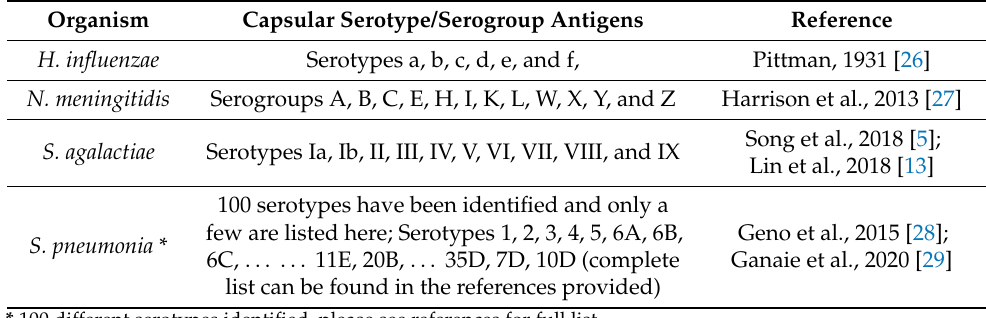
Table 1. Capsular antigens of Haemophilus influenzae , Neisseria meningitidis , Streptococcus agalactiae , and S. pneumoniae .